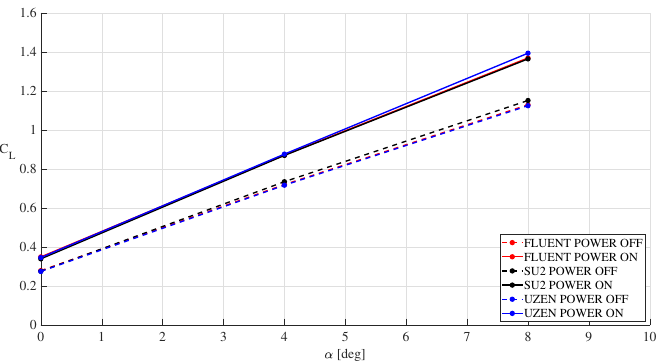
Figure 24. C L curve for power-off and power-on conditions.